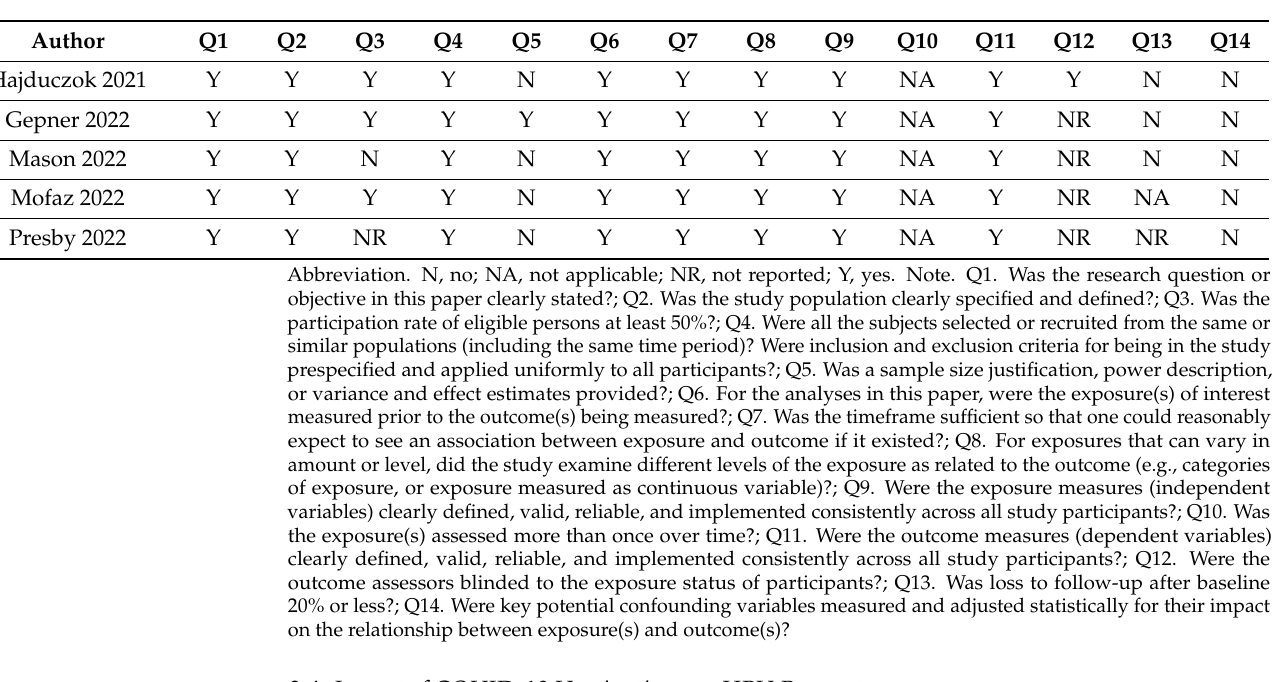
Table 2. Methodological quality of included